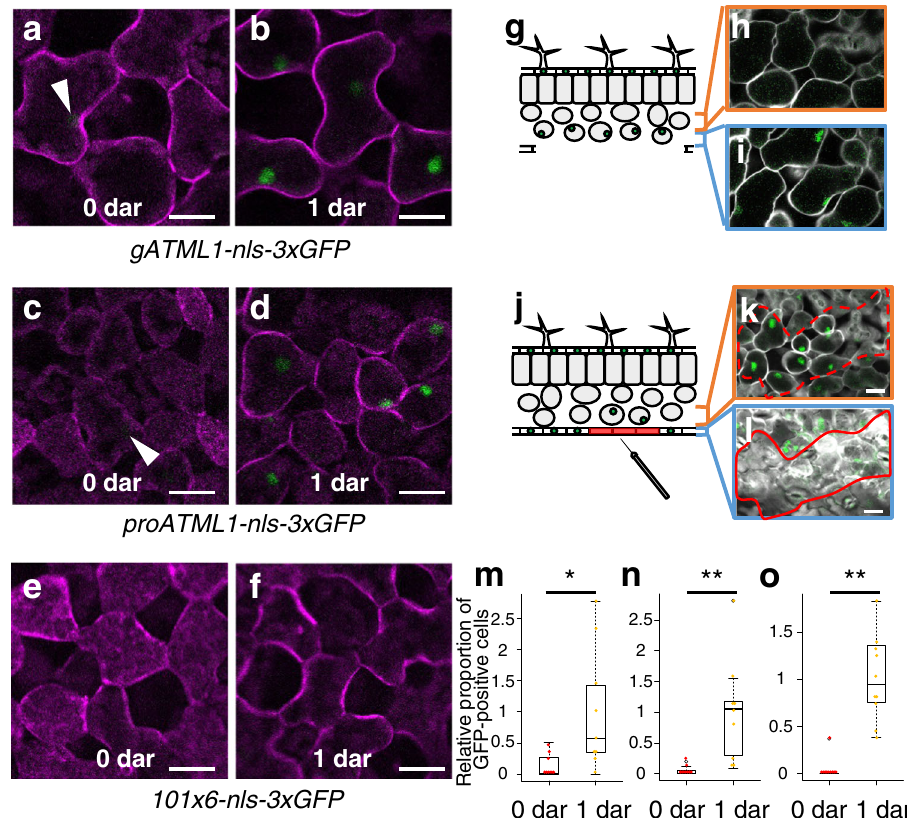
Fig. 1 | ATML1 transcription was activated in the outermost mesophyll cells afterremovaloftheepidermis.a – f Theoutermostmesophyllcellsof gATML1-nls- 3xGFP ( a , b ), proATML1-nls-3xGFP ( c, d ) and 101×6-nls-3xGFP ( e , f ) leaves. The outermost mesophyll cells of 10-day-old plants were observed right after ( a,c,e ) and one day after ( b , d , f ) removal of the epidermis (0 dar and 1 dar, respectively; dar,dayafterremovaloftheepidermis).Whitearrowheadsindicate ATML1 -positive nuclei. g Schematic drawing of a transverse leaf section with a part of abaxial (lower) epidermis removed. h , i Inner mesophyll cells ( h ) and the outermost mesophyllcells( i )ofa10-day-old proATML1-nls-3xGFP seedlingat1dar. j Schematic drawing of a leaf transverse section with a part of abaxial epidermis injured (highlighted in red). k , l The epidermis of a 9-day-old proATML1-nls-3xGFP leaf was damaged with a needle, and mesophyll ( k ) and epidermal ( l ) cells were observed